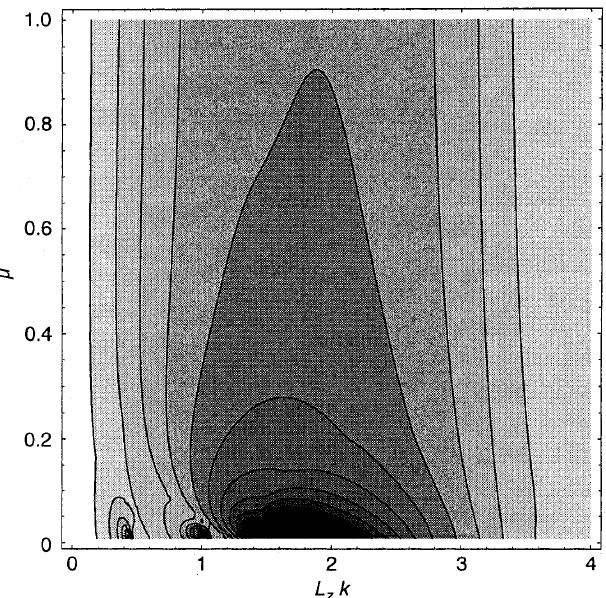
Fig. 3. Contour plot of maximum growth rates max n (cid:133) Im m n (cid:134) as a function of wave number L z k and mass ratio l for a marginally